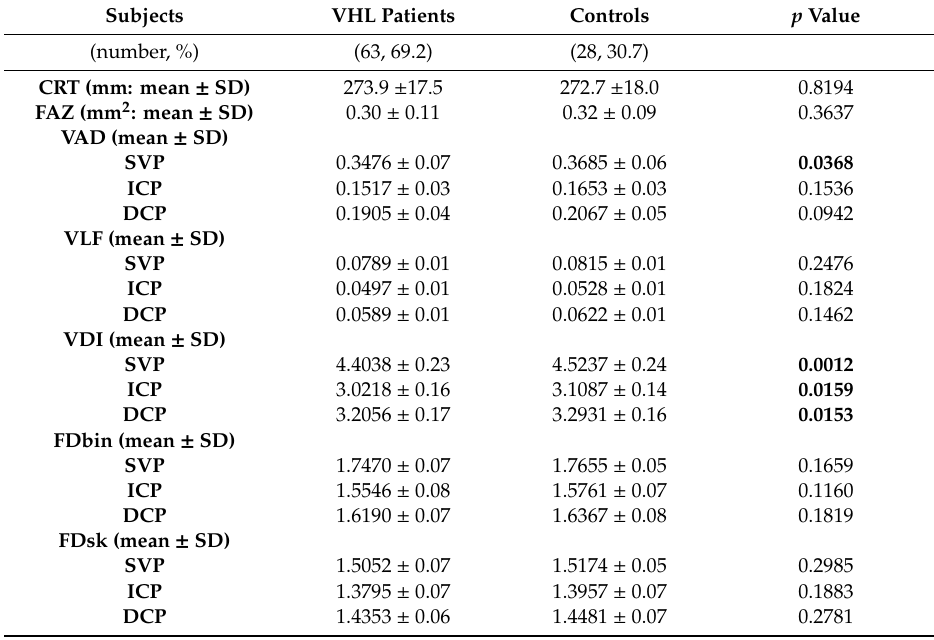
Table 2. OCT and OCT angiography parameters in von Hippel-Lindau patients and healthy controls.